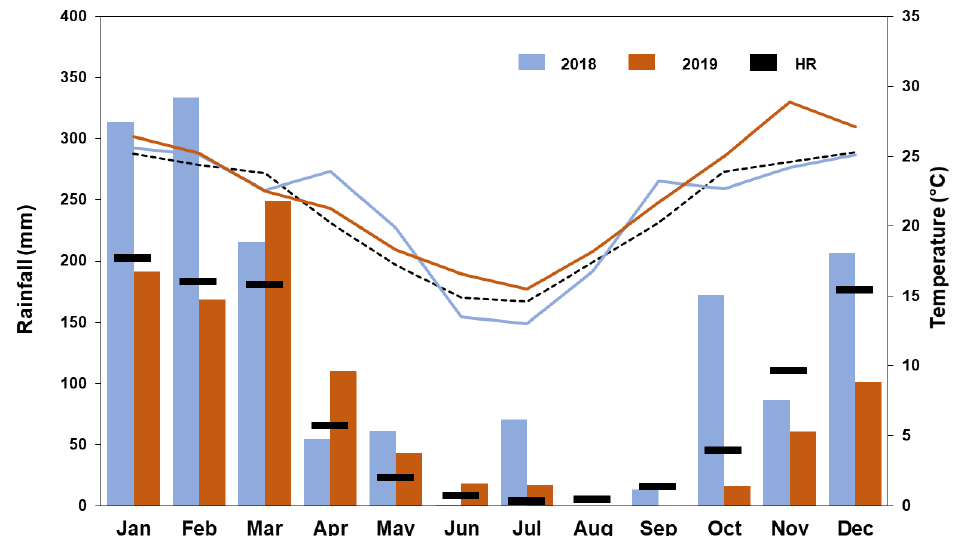
Figure 2. Historical records (HR) of rainfall and temperature (1981–2010); and rainfall and average temperature for the years 2018 and 2019 registered in the study area, according to data from SMN. The dashed black line shows the historical temperatures calculated with the average monthly temperatures.